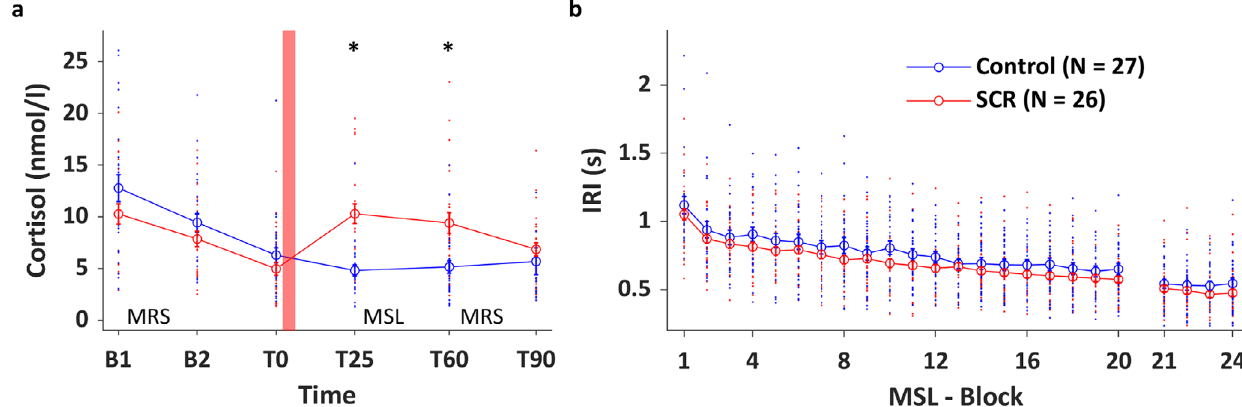
Fig. 2 Effectiveness of the stress induction and MSL performance. Individual data plotted on top of group averages. a Time course of salivary cortisol concentration (nmol/L). B1 and B2, Baseline 1 and 2. MRS, MR spectroscopy. The red box represents the control/stress intervention (~T0). In the SCR